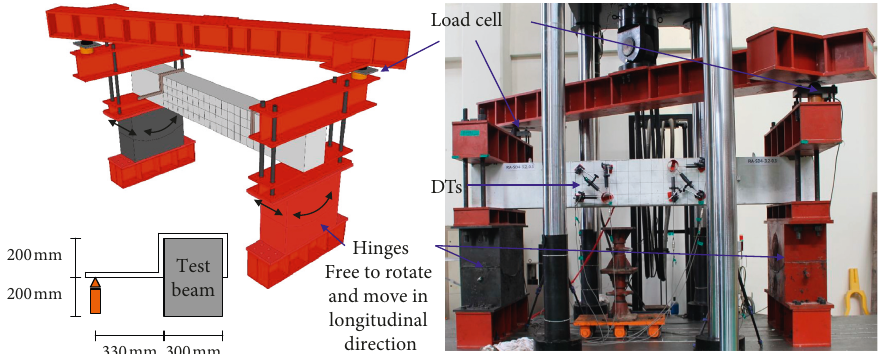
Figure 4: Setup of the torsion test.